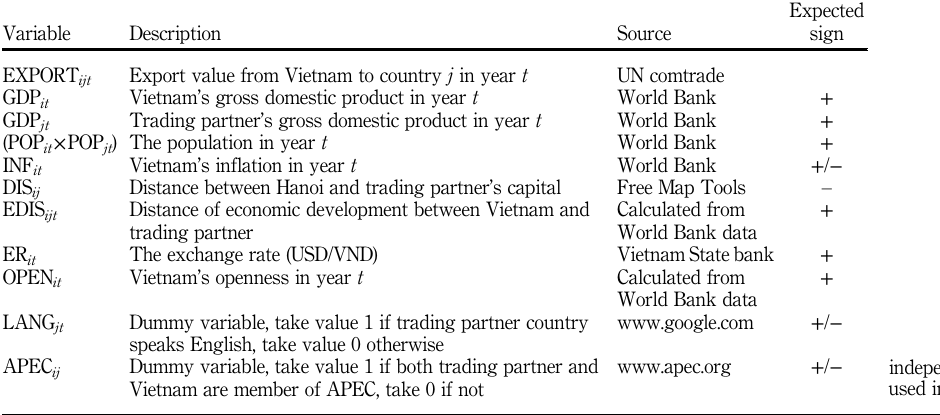
Table III. Summary